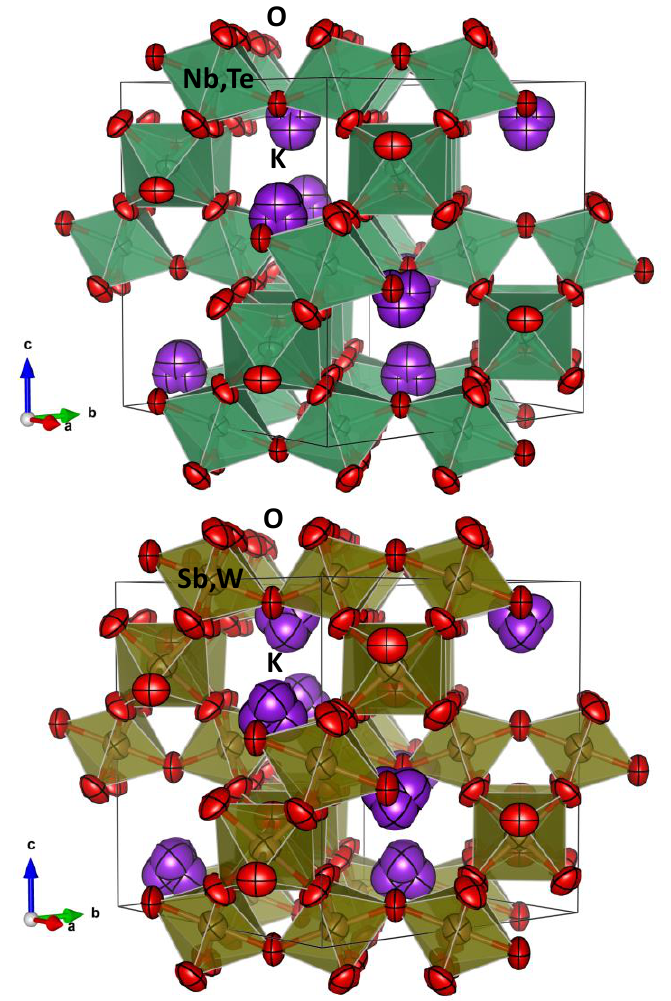
Figure 6. View of the ( a ) KNbTe and ( b ) KSbW pyrochlore structures, approximately along [110] direction. Here, green ( a ) and brown ( b ) octahedra depict the (B V ,B VI )O 6 covalent